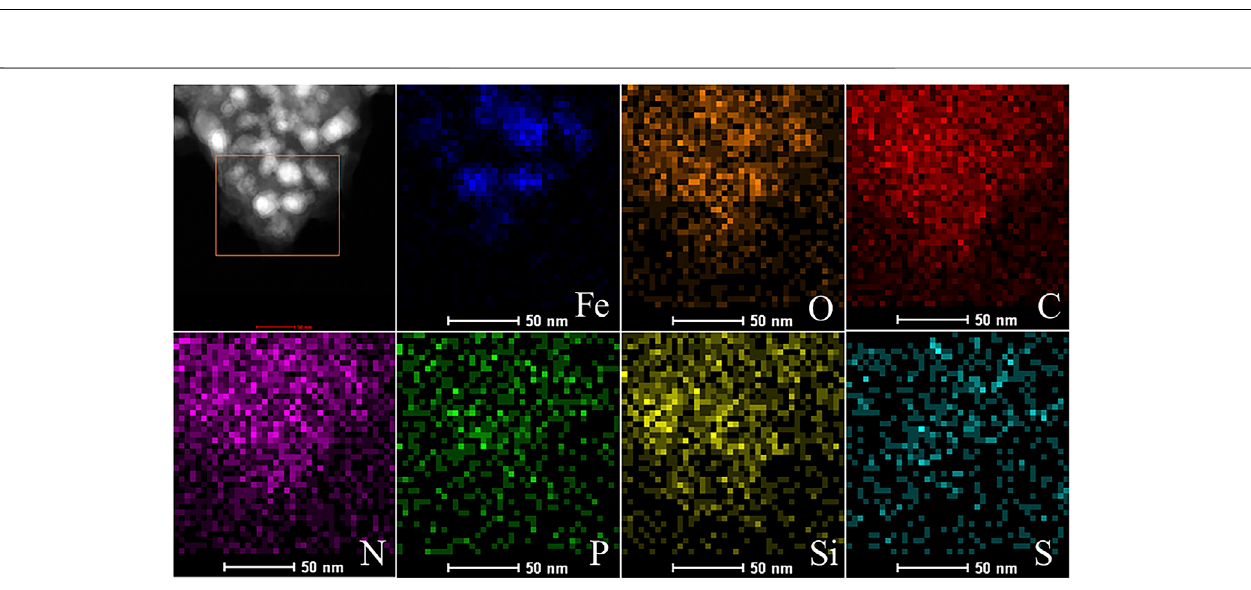
FIGURE 3 | EDS mapping images of